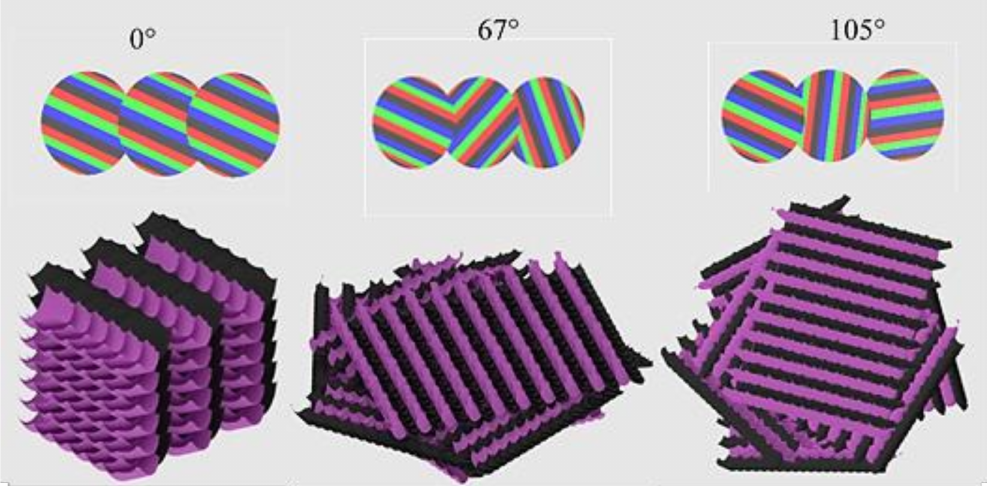
Figure 9. ( Top ) scan pattern rotation, ( bottom ) developed